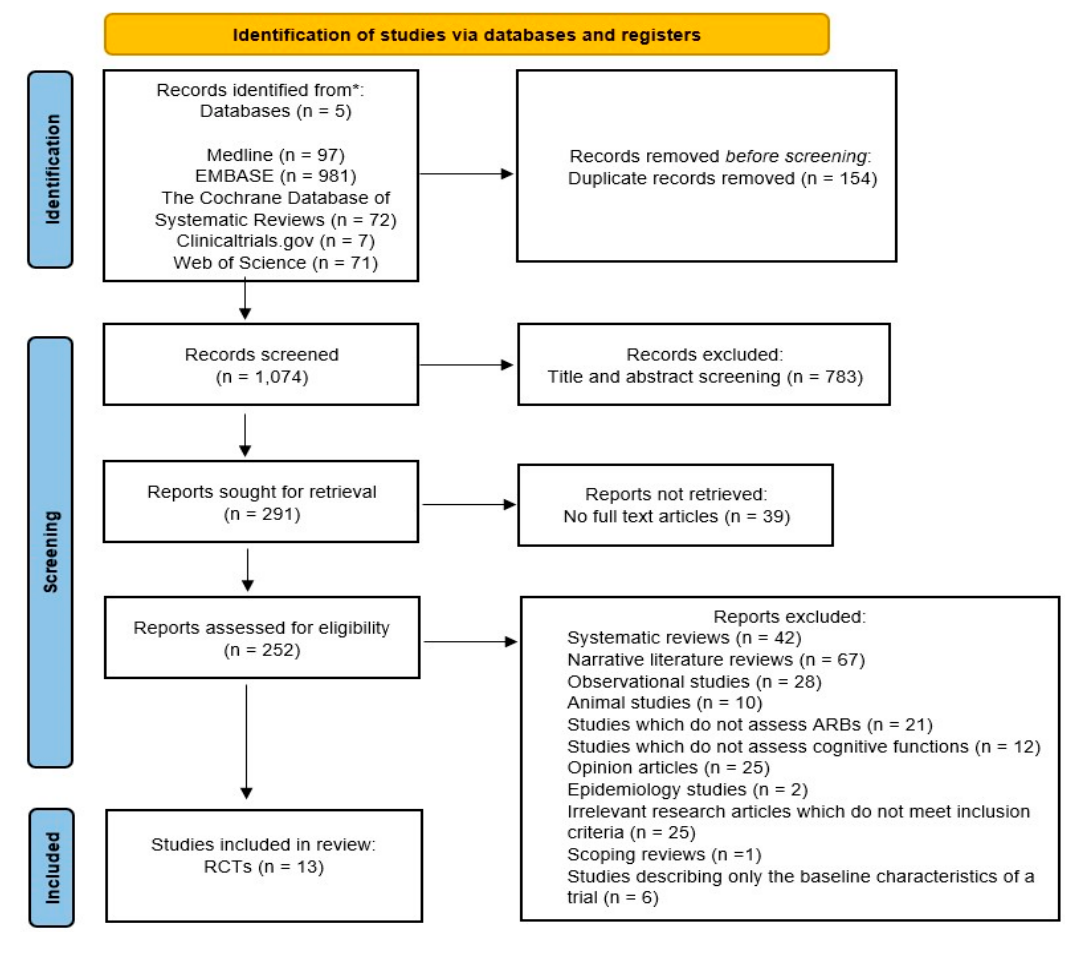
Figure 1. PRISMA diagram. Details of the screening process involved to exclude irrelevant references, which do not meet the inclusion criteria, in order to find appropriate literature to assess the effects of ARBs on cognition or dementia, presented using a PRISMA flowchart [20]. Table 5. The study characteristics for the included 13 RCTs which detail the population sample, age, patient characteristics, follow-up years, intervention with dosage, outcomes, psychometric tests, study design, and summary of results.